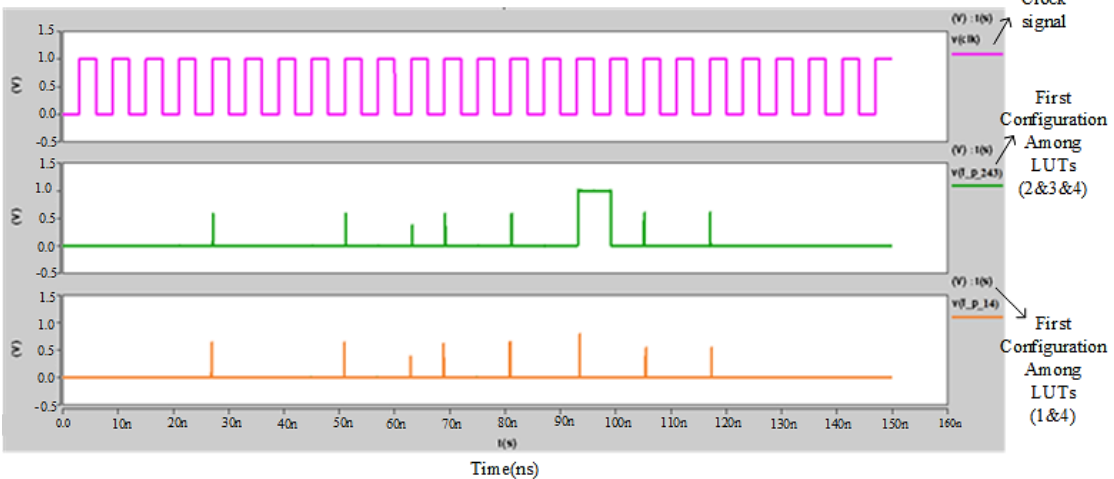
Figure13. ORA outputs for 13 th cell be faulty in 3 rd LUT in configuration 1.